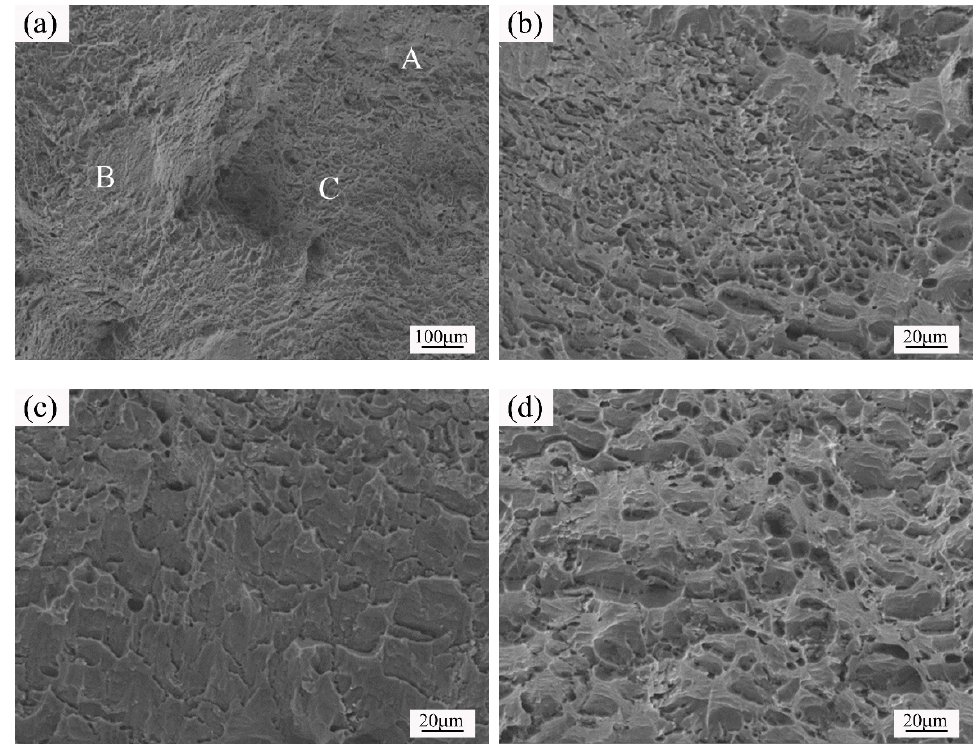
Figure 16. SEM micrographs of tensile fracture specimen: ( a ) whole area; ( b ) position A; ( c ) position B; ( d ) position C.